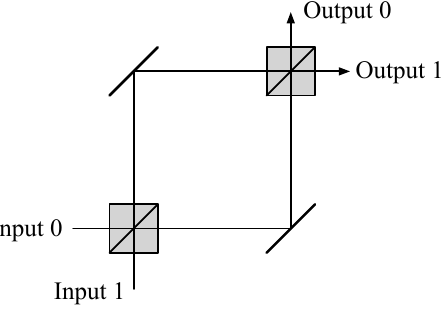
Figure 1. An example of a quantum NOT